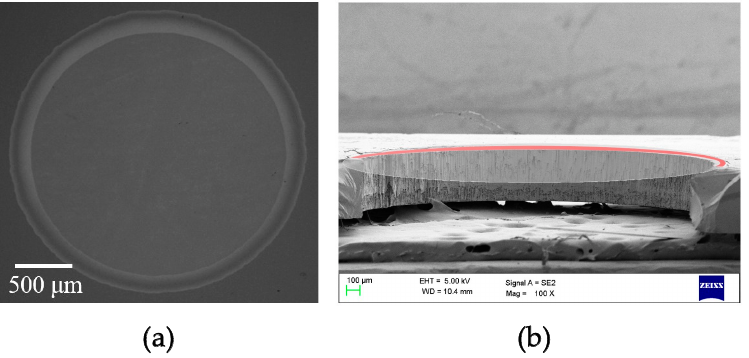
Figure 11. Microscope photograph of the top ( a ) and cross-section ( b ) view of a fabricated electrostatic MEMS speaker [85]. The diaphragm was removed in ( b ) for obtaining a clearer view of the